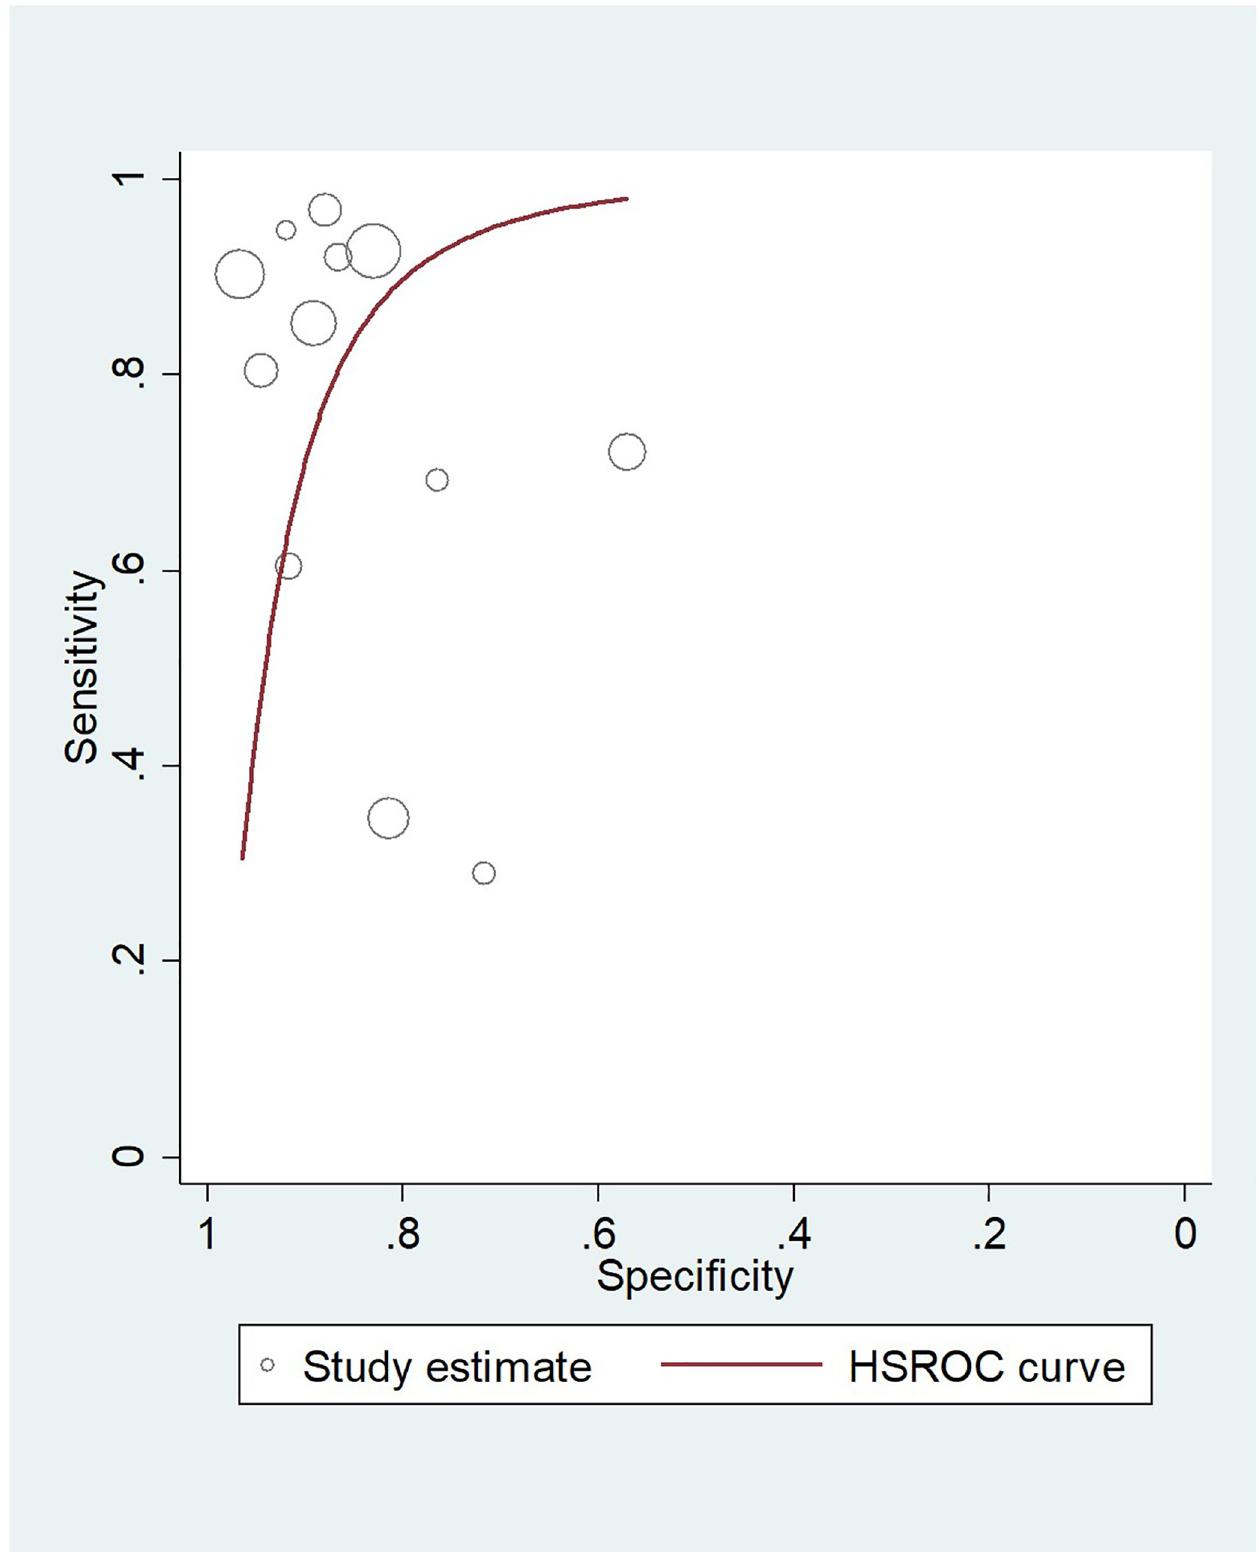
Fig 3. HSROC plot for the diagnostic accuracy of antenatal ultrasound to predict nuchal cord at birth. https://doi.org/10.1371/journal.pone.0239630.g003 PLOS ONE | https://doi.org/10.1371/journal.pone.0239630 September 24,